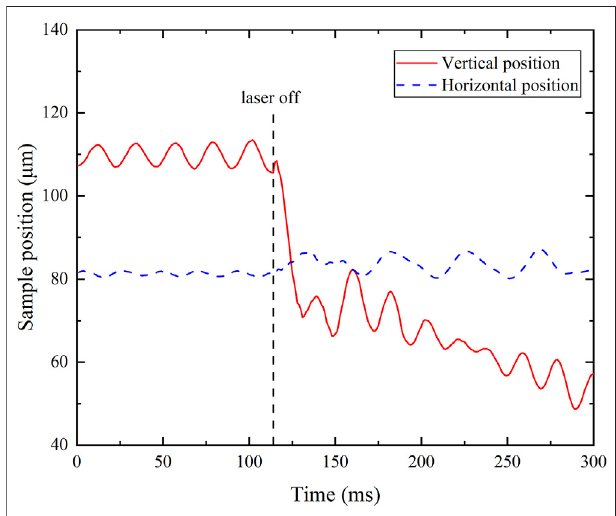
FIGURE 6 | Temperature-dependent density of liquid alumina. Density and temperature dataofthepresent experimenthave errorbarsof1.40%and 0.5% respectively.